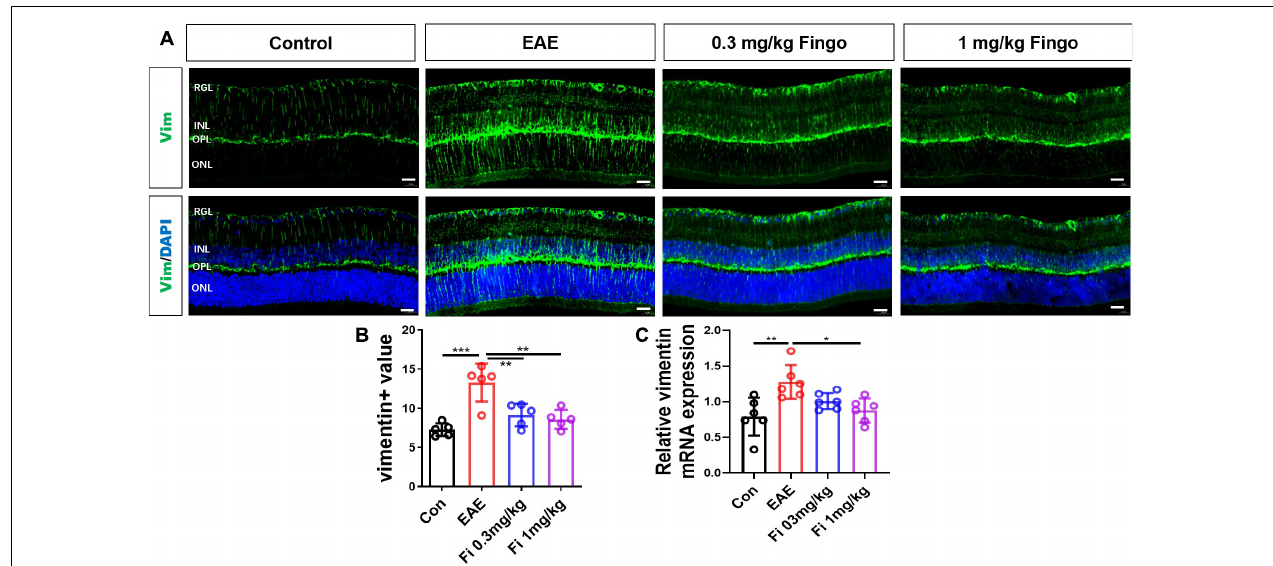
FIGURE 6 | Morphological and mean gray value changes of vimentin + cells. (A) Vimentin antibody was used to label the Müller cells in the retina. Vimentin + cells had a longer process, which extended from OPL to deeper ONL and RGL in the EAE group. (B) Comparison of Vimentin mean gray values among groups. (C) Vimentin mRNA expression in the retina. RGL, retinal ganglion layer; INL, inner nuclear layer; OPL, outer plexiform layer; ONL, outer nuclear layer. Values represent mean ± SD. One-way ANOVA plus Tukey’s multiple comparisons. * P < 0.05, ** P < 0.01, *** P < 0.001. Scale bar = 20 µ